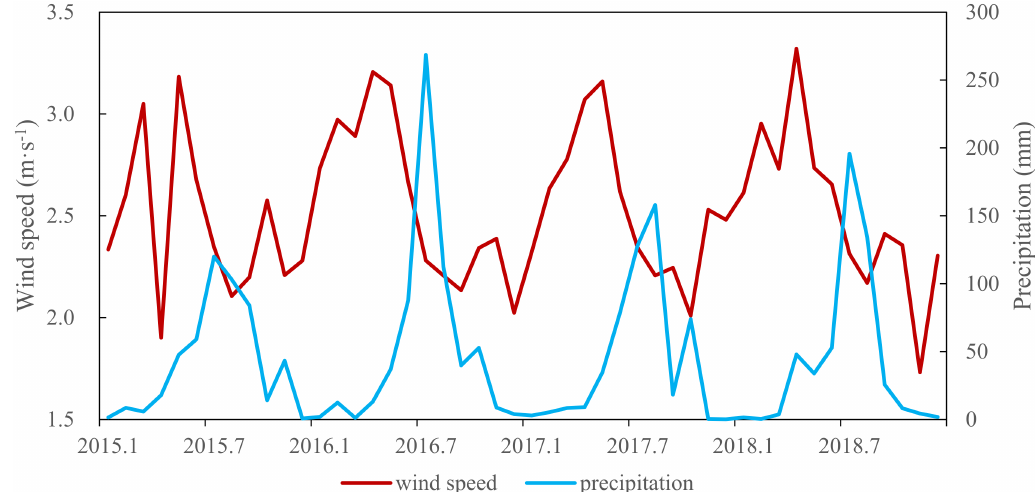
Figure 6. Variation trend of meteorological factors in the study area.